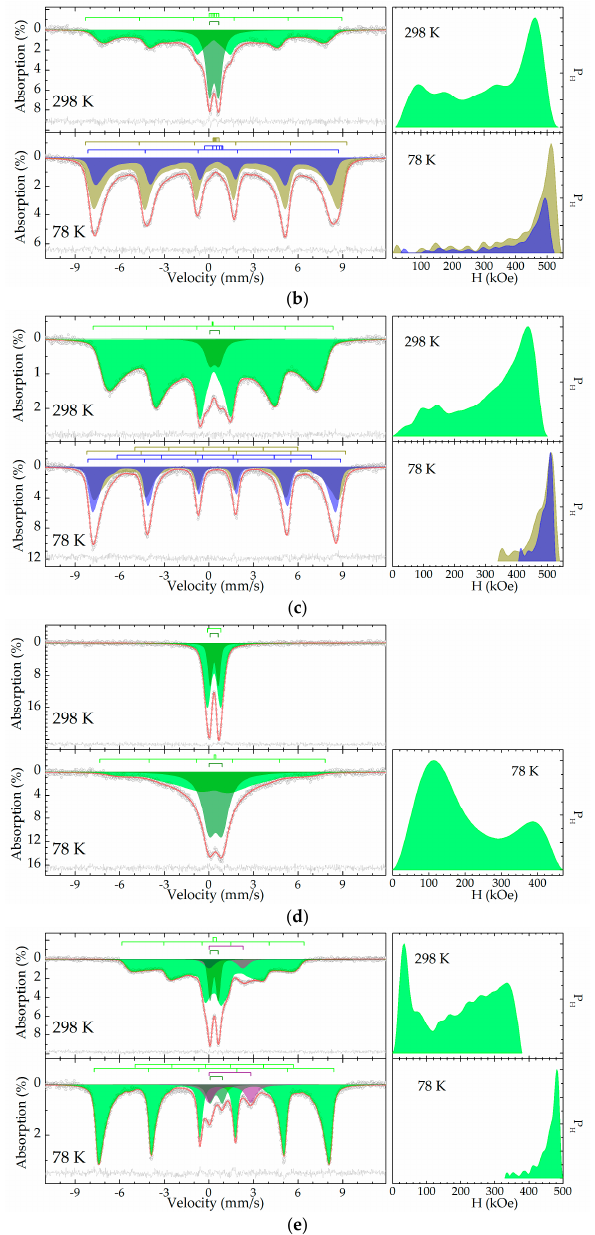
Figure 2. Mössbauer spectra at various temperatures, description models, and distribution of the probability function for magnetic fields of samples: ( a ) Fe 3 O 4 , ( b ) γ -Fe 2 O 3 , ( c ) δ -FeOOH, ( d )